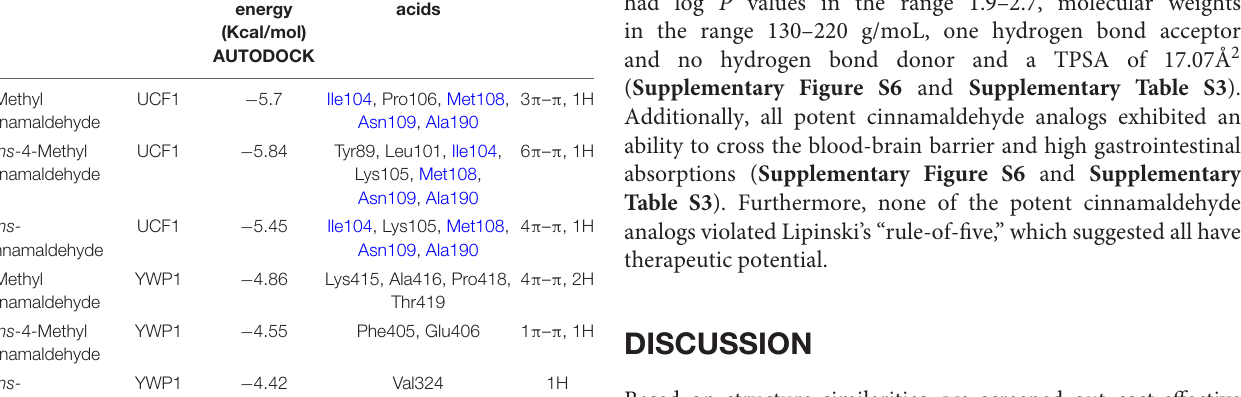
TABLE 1 | Binding energies of targeted ligands with UCF1 or YWP1 proteins. Compounds